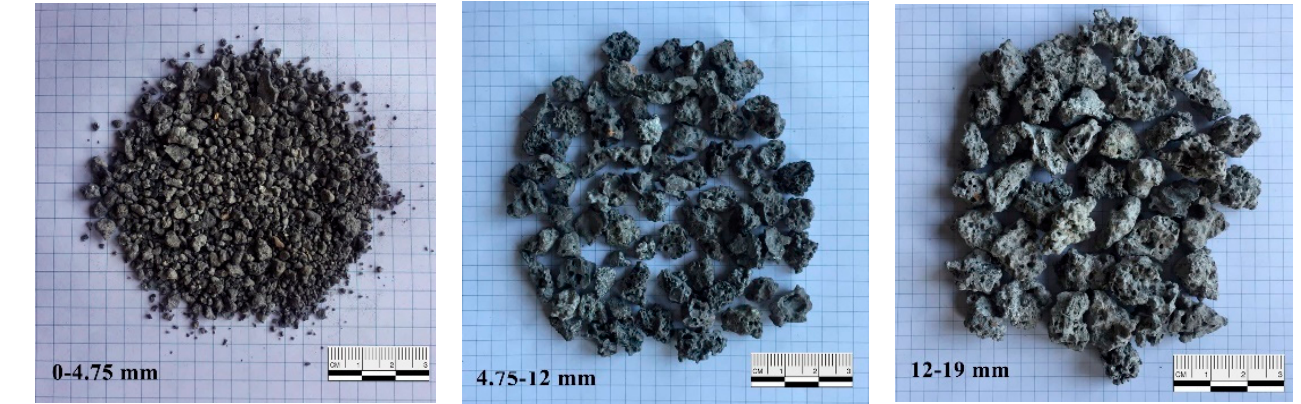
Figure 2. EAFS aggregate sizes used. Figure 1. EAFS aggregate sizes used.